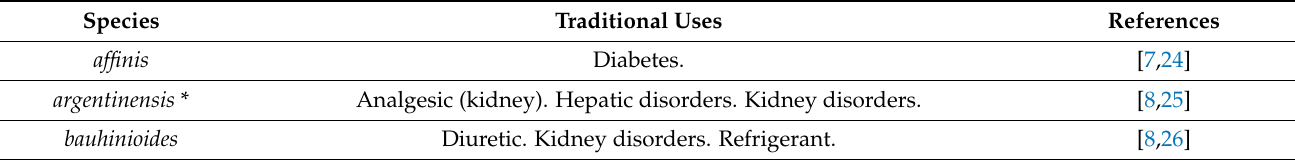
Table 1. Main traditional uses of austral South American Bauhinia